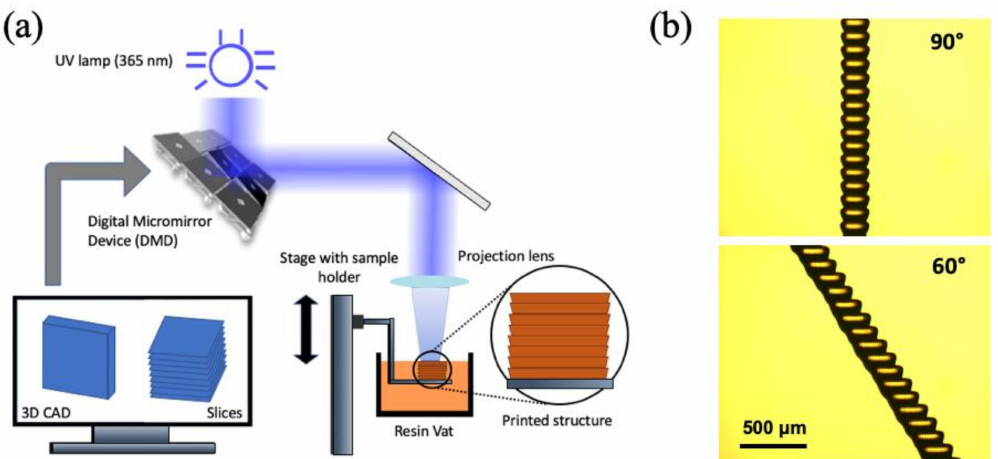
Figure 1. ( a ) Schematic diagram of P µ SL and resulting surface roughness on a printed part. ( b ) Microscope images of 3D printed struts in different printing angles (90 ◦ and 60 ◦ ). The polymer used is HDDA and curing time per 80 µ m thick layer is 3 s. These side profiles clearly display the surface roughness caused by the layer-wise